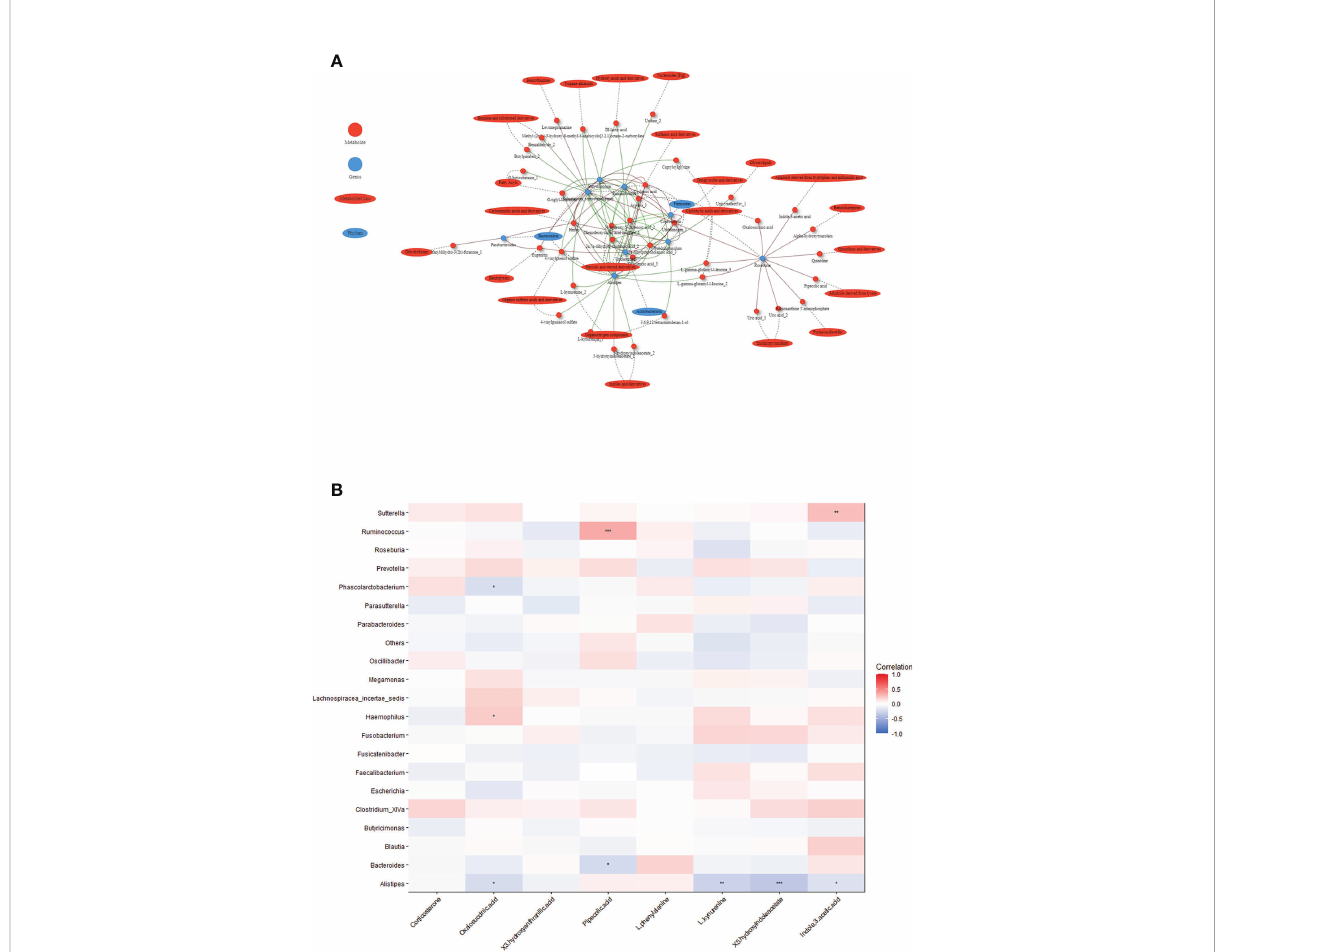
FIGURE 4 Associations between serum metabolites and altered gut microbiota. (A) Network of the Spearman ’ s rank correlation coef fi cient between metabolites class and gut microbes. (red circles: metabolites; blue ovals: microbes; red lines: positive correlation; green lines: negative correlation). (B) Heatmap of correlation between altered metabolites and gut bacteria at the genus level. The colors in the heatmap represent the positive (represented by pink) or negative correlation (represented by blue). The Benjamini-Hochberg false discovery rate was used to correct p values for multiple testing. *p<0.05, **p<0.01,